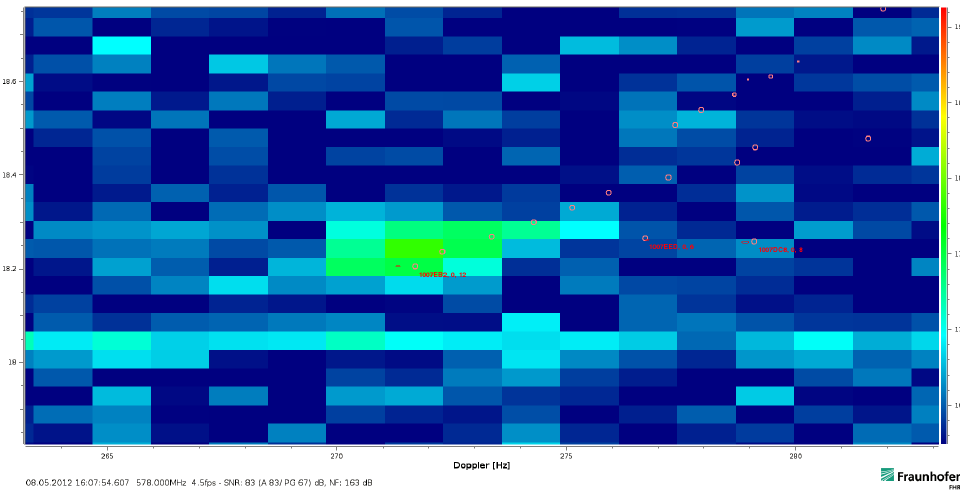
Figure 14. Target previously shown in Figure 5 tracked with a bistatic velocity v eff ≈ 270km/h over T cov = 896ms with T int = 717ms, decelerated and noise overlapped that gave multiple track